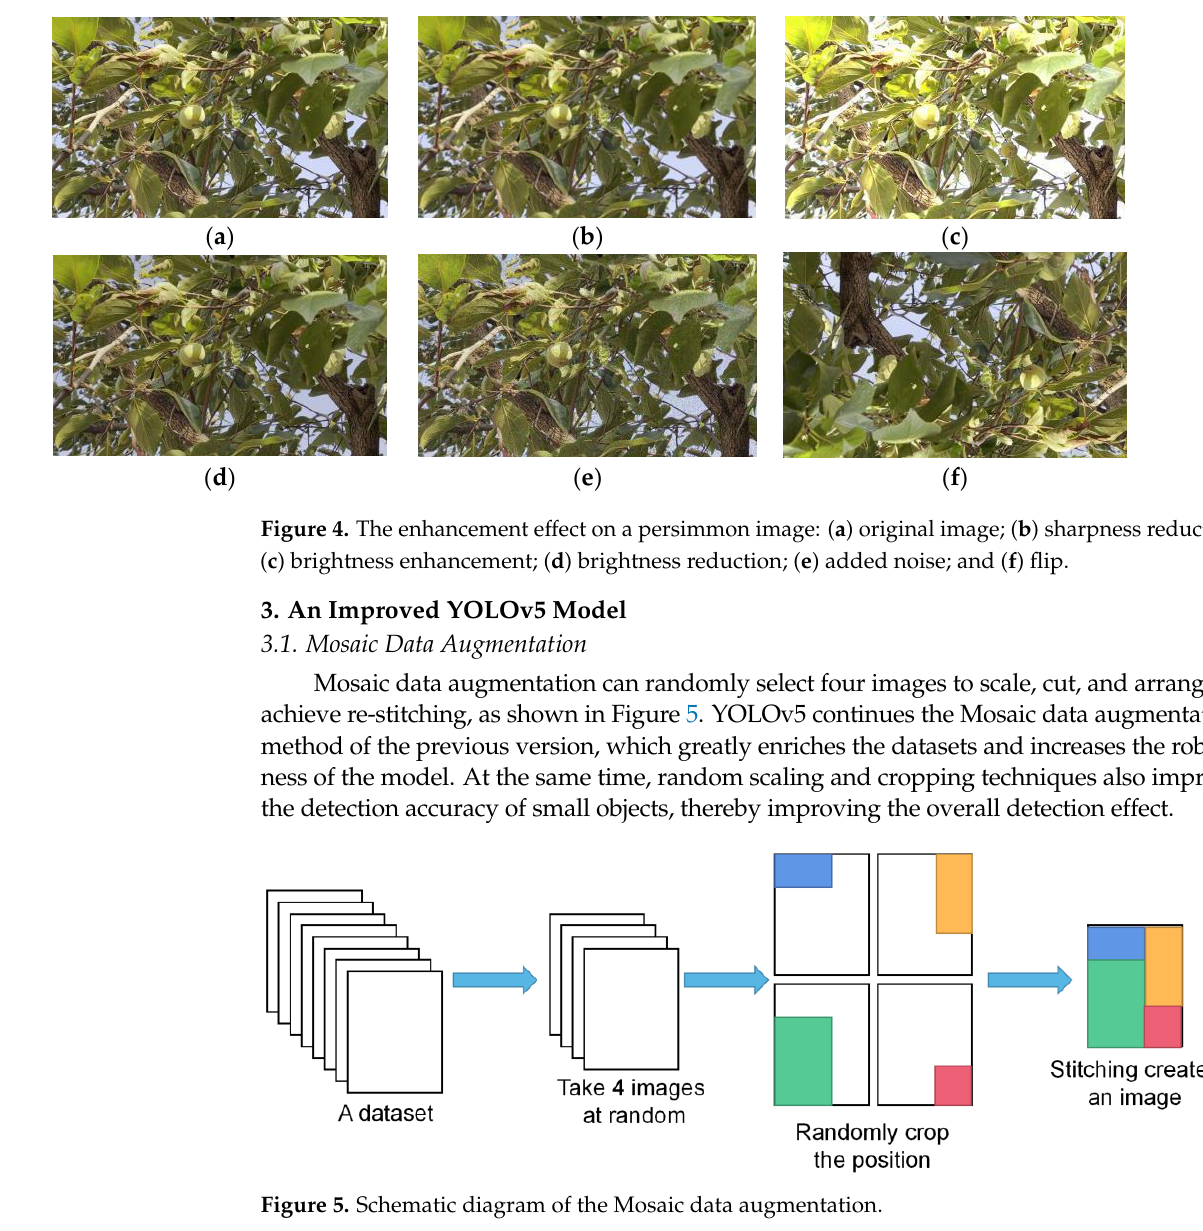
Figure 3. Dataset acquisition device.